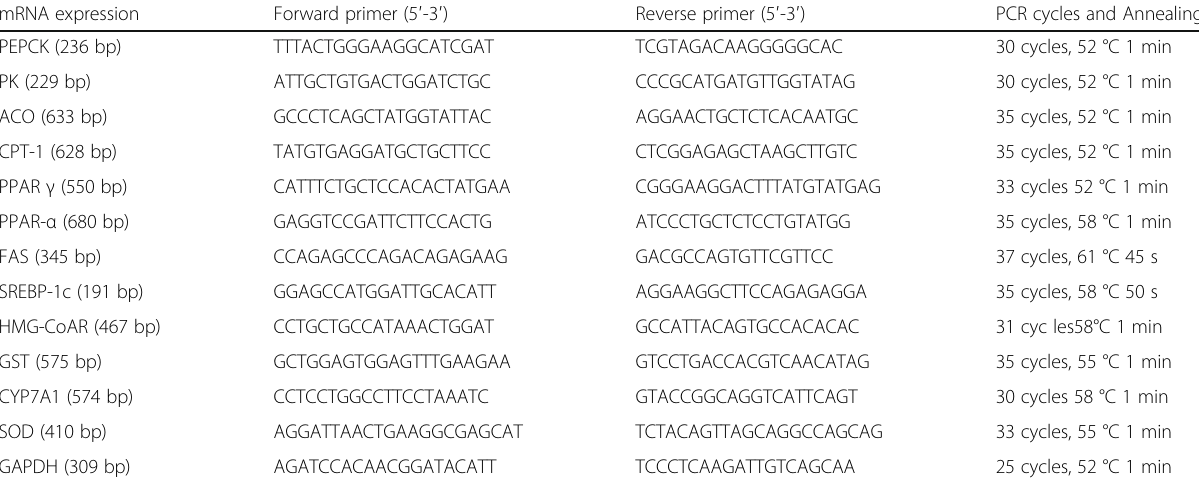
Table 1 PCR conditions and primer sequence for examined genes mRNA